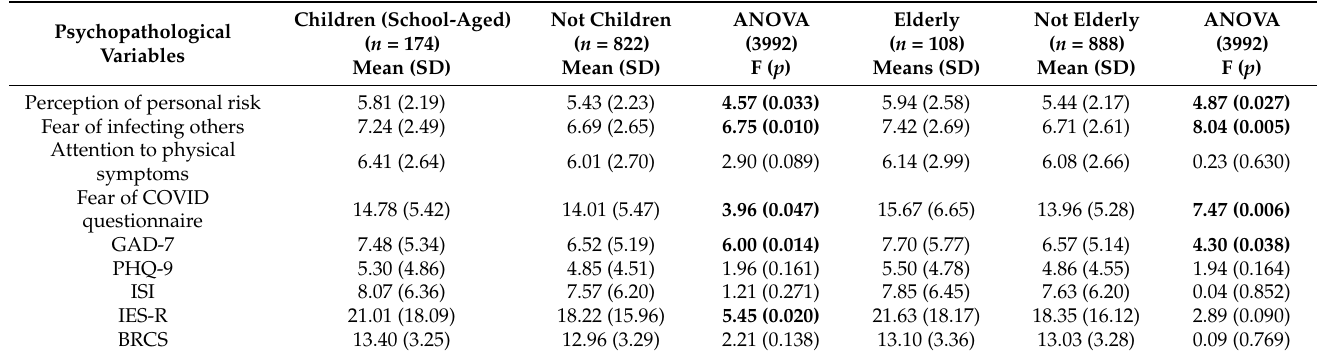
Table 5. Psychopathological scores in HCWs by living with school-aged children and elderly.